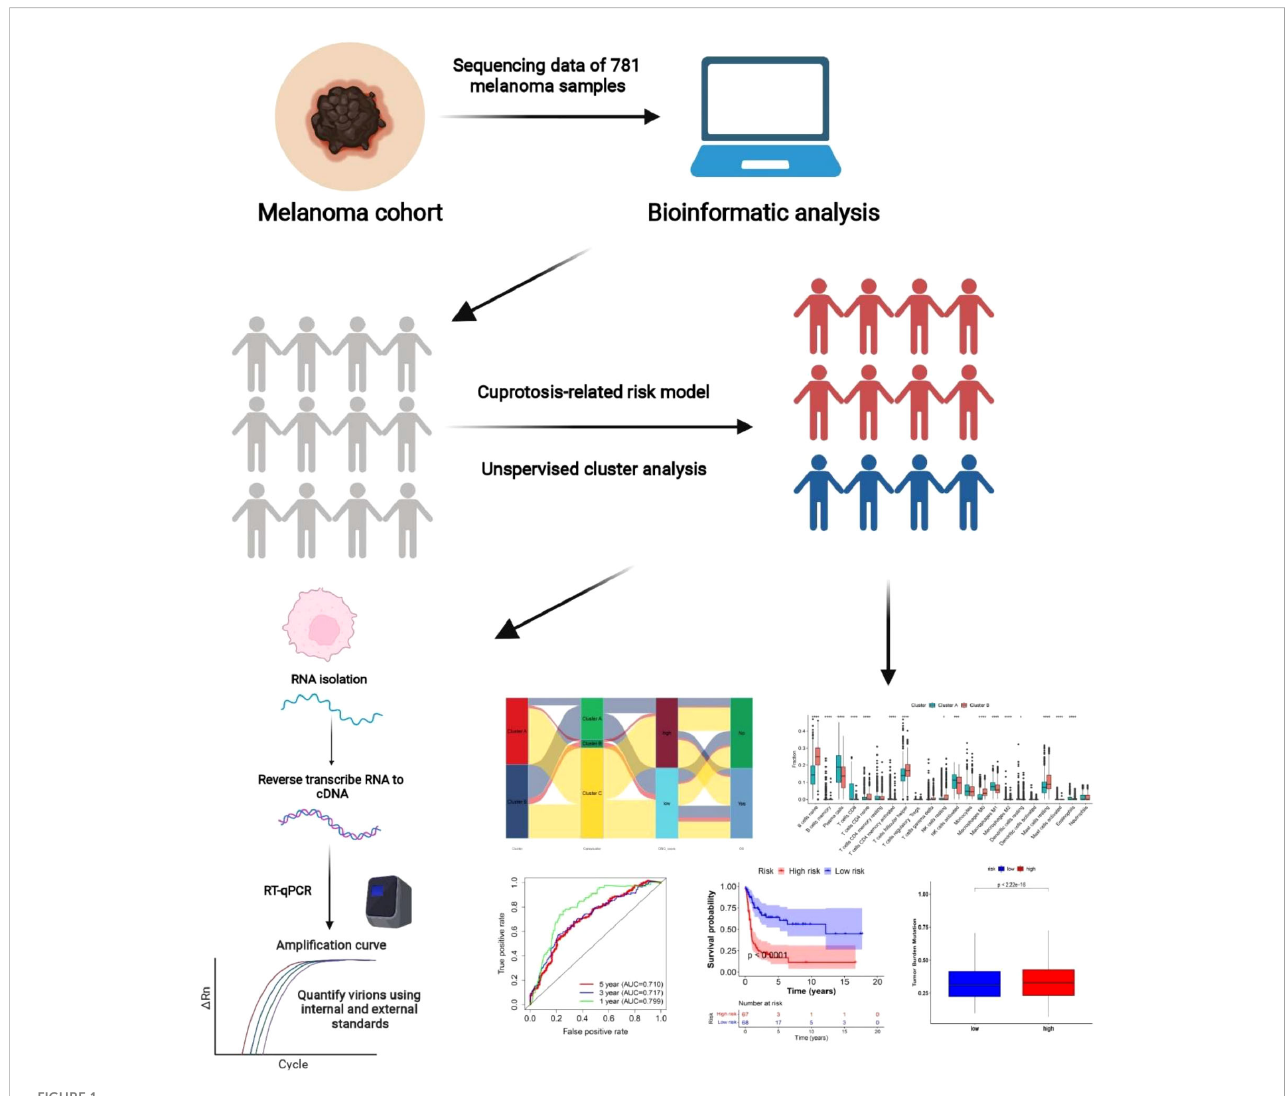
FIGURE 1 Graphical illustration of our present